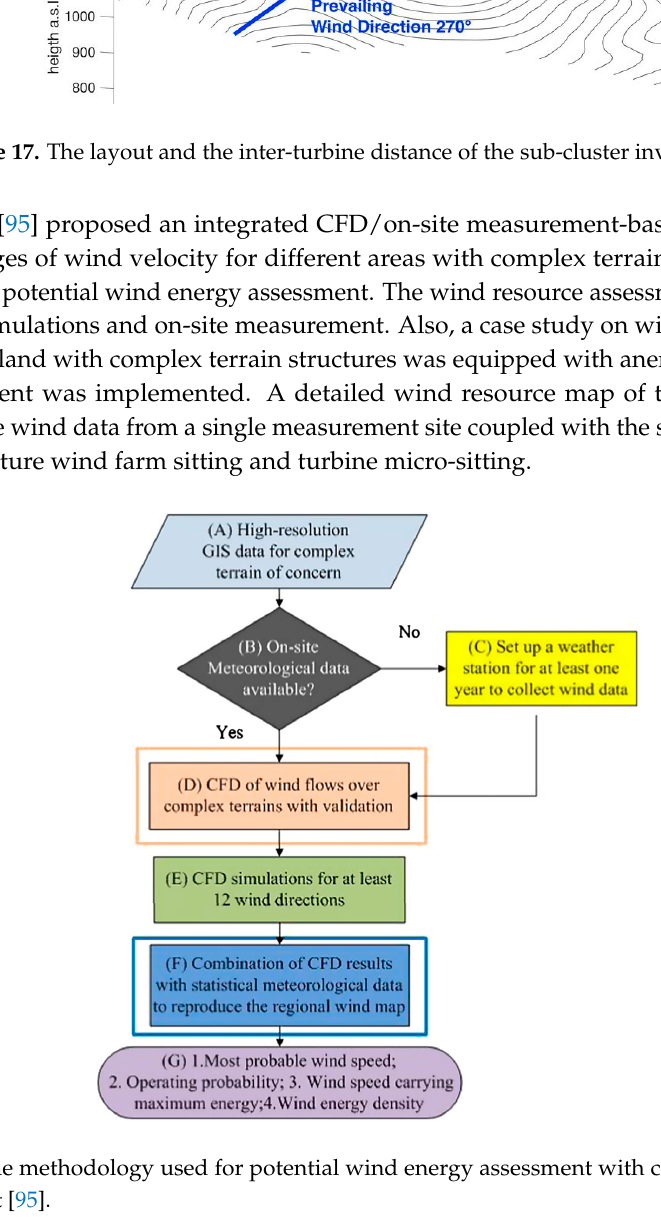
Figure 17. The layout and the inter-turbine distance of the sub-cluster investigated [3].